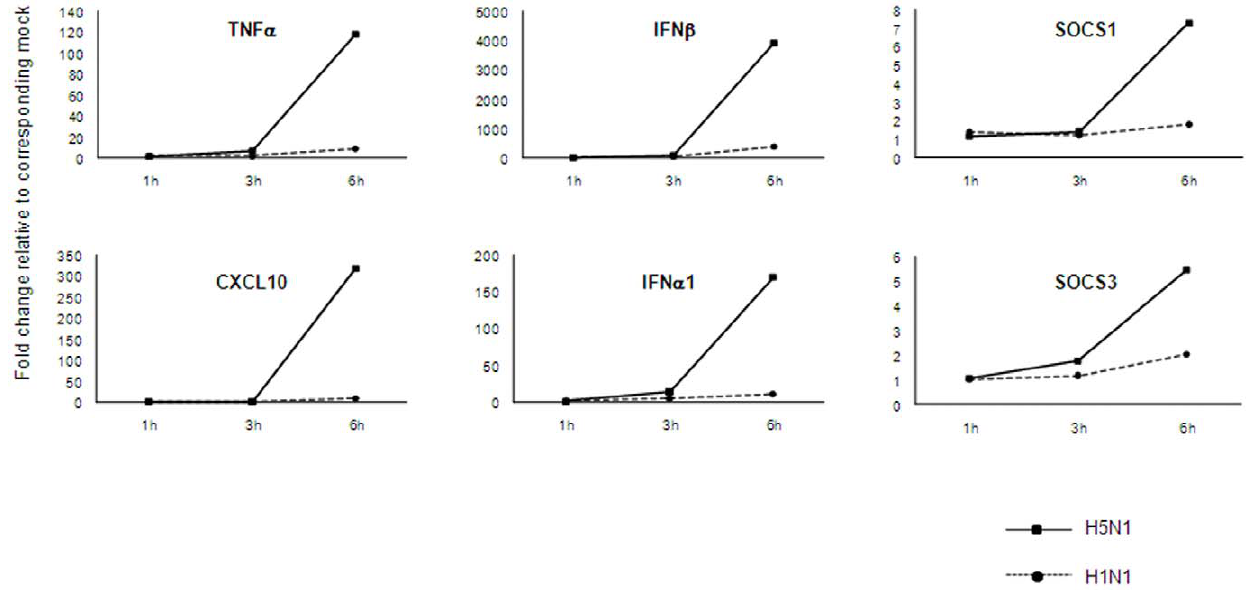
Figure 2. Validation of microarray data by real time PCR. Expression of six genes was assessed at 1, 3 and 6 h after infection by influenza A compared to mock infection. Data presented was from one representative donor and showed similar expression patterns compared with the microarray experiment.